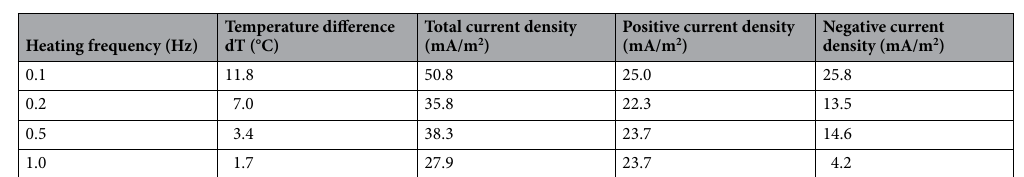
Table 3. Temperature range and current density for a range of heating repetition rates.